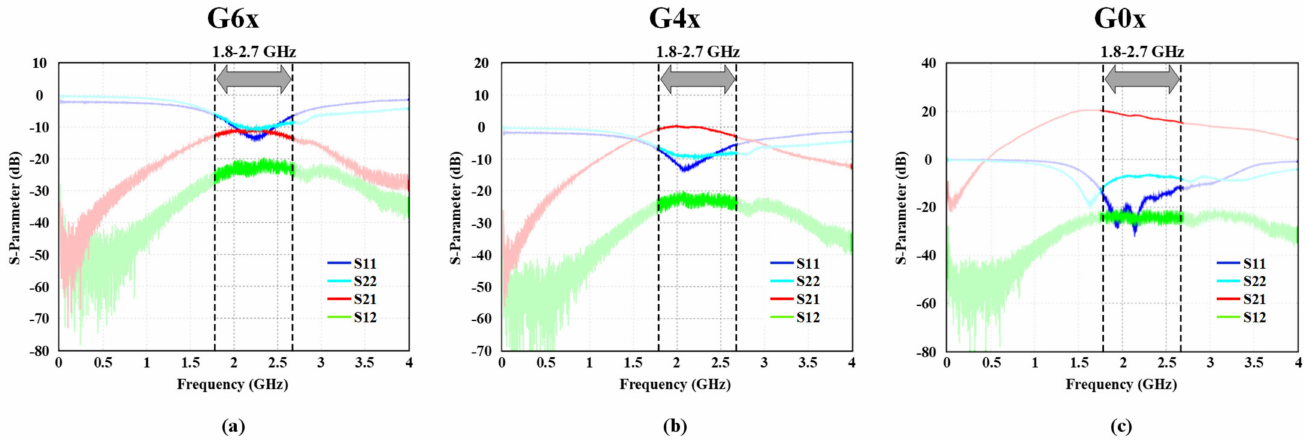
Figure 9. Measured S-parameter results in Mode0 for LB frequencies: ( a ) − 11 dB of power gain step, ( b ) 0 dB of power gain step, and ( c ) 20.5 dB of power gain